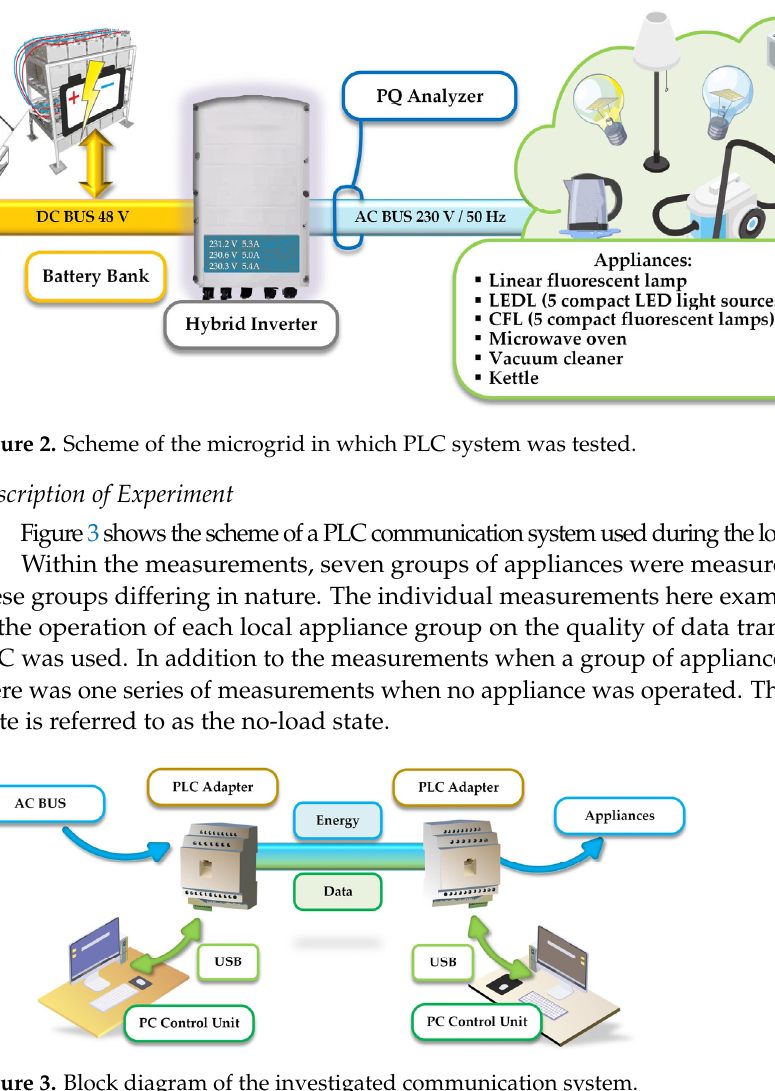
Figure 3. Block diagram of the investigated communication system.